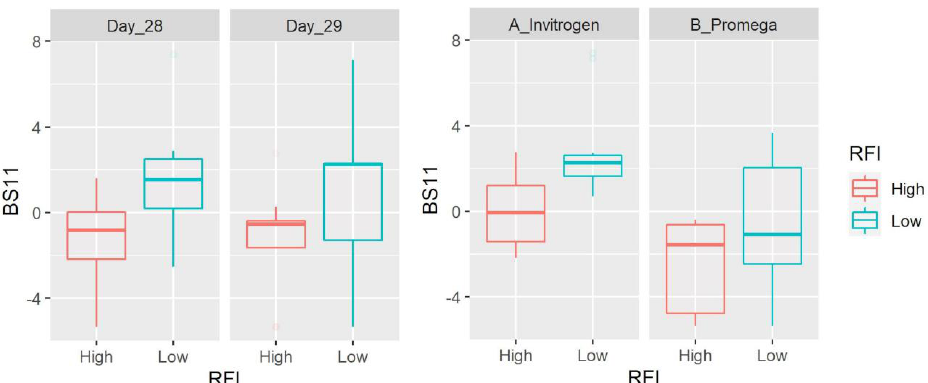
Figure 2. Box plots showing the abundance of BS11 (Bacteroidetes) based on clr-transformed data. Data are shown for both day of sampling and DNA extraction method. There was a significant difference between LRFI and HRFI ( p = 0.0021) and DNA extraction methods ( p = 0.0003), with no time effect.